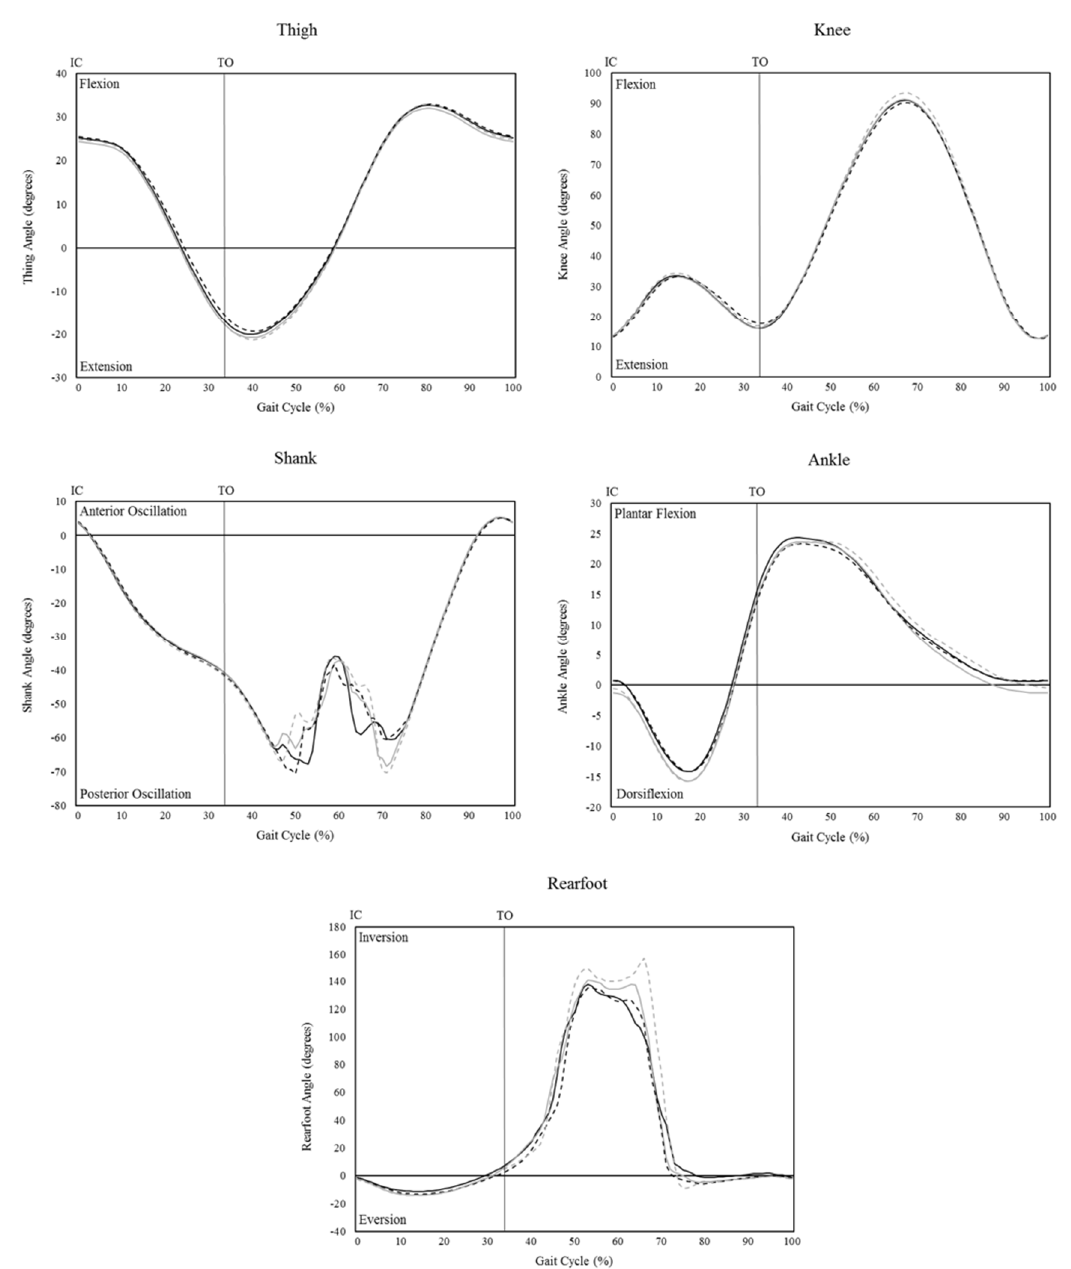
Figure 5. Angular kinematics of thigh, knee, shank, ankle, and rearfoot in peripheral pre-fatigue (continuous black line), peripheral post-fatigue (dotted black line), central pre-fatigue (continuous gray line), and central post-fatigue (dotted gray line). IC: Initial Contact. TO: Toe-Off.